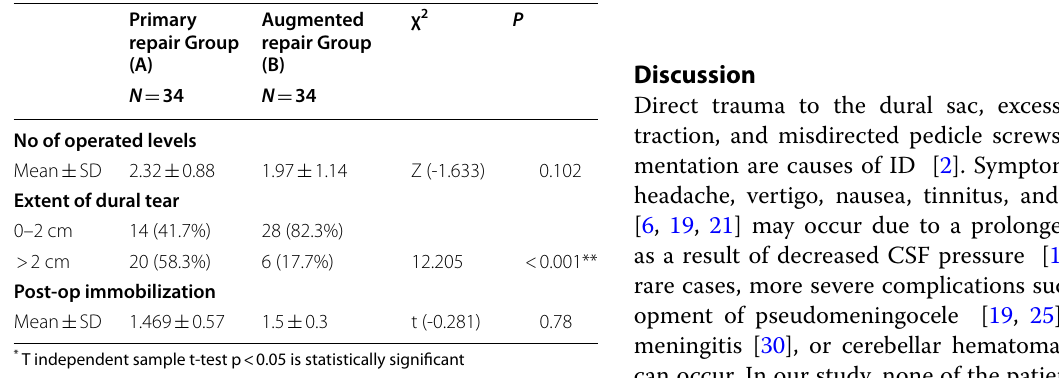
Table 2 operative variables of the studied groups